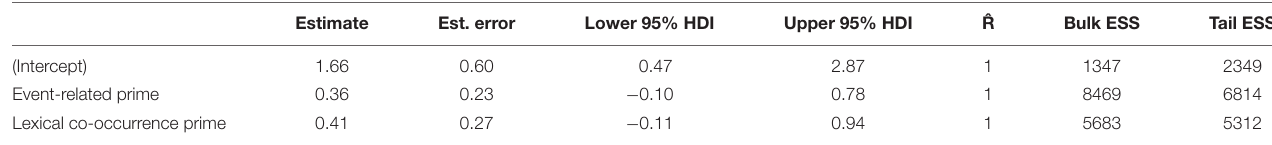
TABLE 8 | Model 3 primed naming accuracy population-level effects for participants with aphasia.